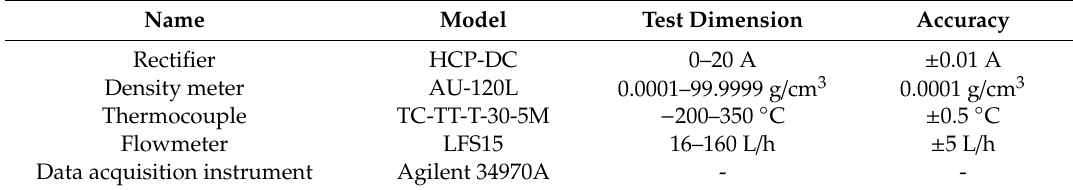
Table 1. Test instrument and accuracy.